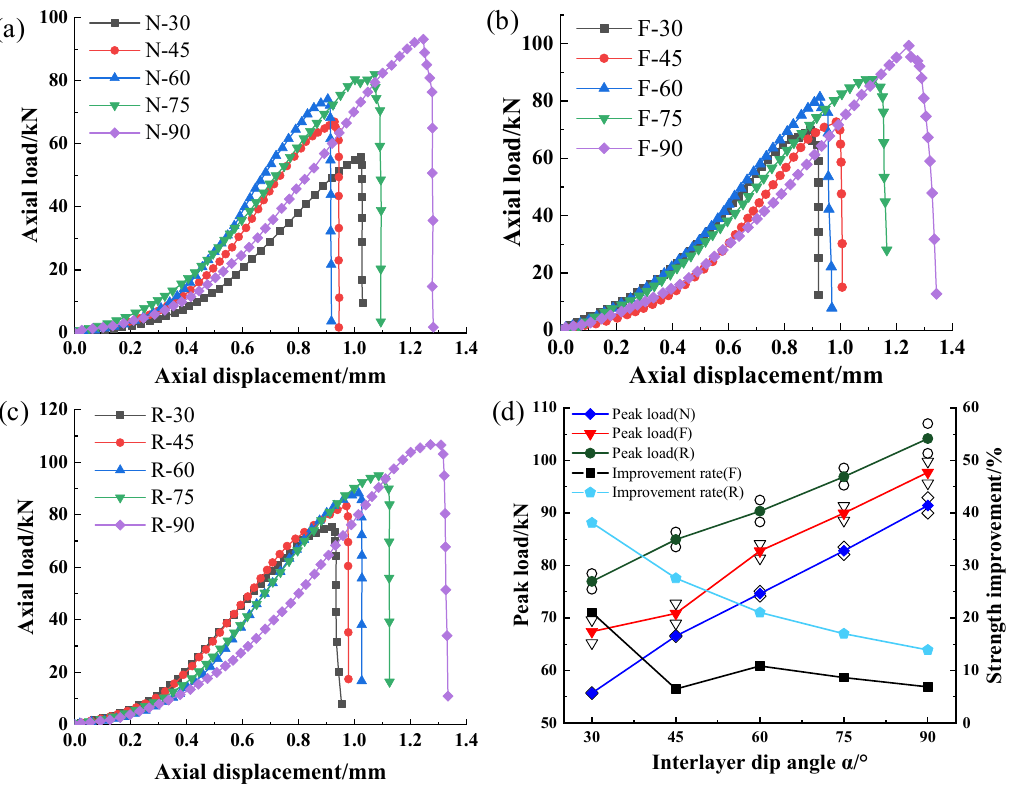
Figure 9. Force–displacement curves and peak load relationships: ( a ) unanchored sample; ( b ) free- ends anchored sample; ( c ) restrained-ends anchored sample; ( d ) peak load and improvement rate.